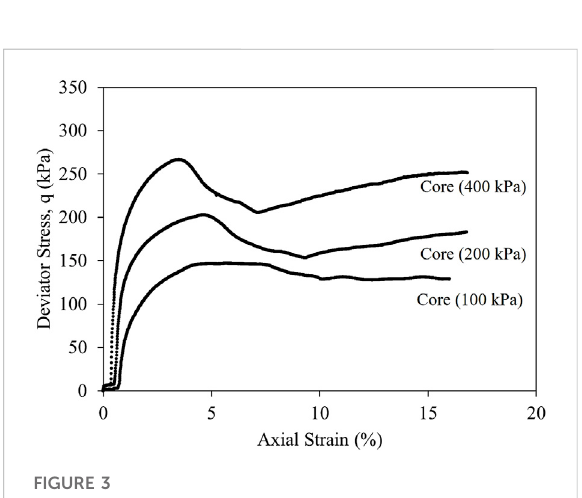
FIGURE 3 Stress-strain behavior from CIU triaxial tests on CB clay core